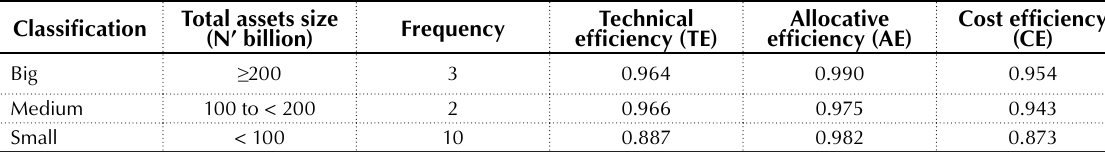
Table 5. Measured mean efficiency of the deposit money banks in